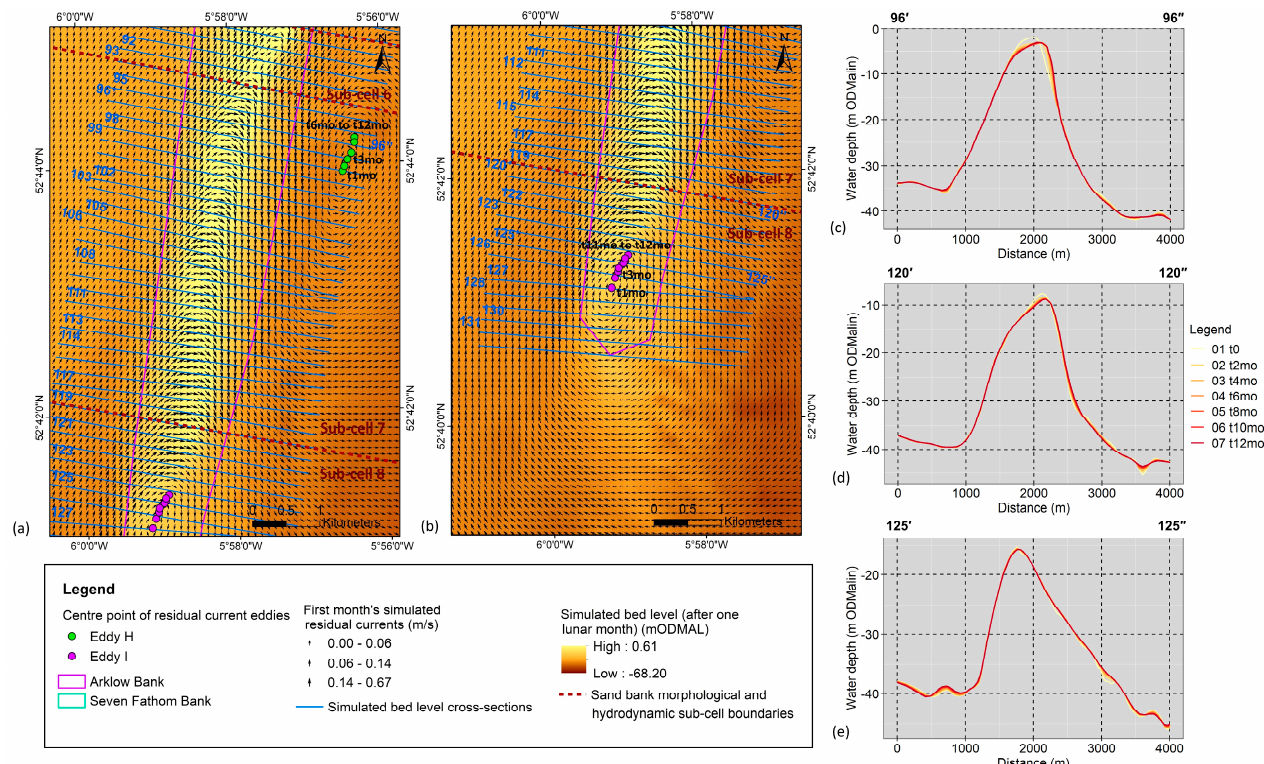
Figure 11. Morphodynamics and hydrodynamics at Sub-cells 7 and 8 of Arklow Bank. ( a , b ) Simulated bed level change after one lunar month and associated residual current vectors, overlain by the location of the centre point of residual eddies from residual currents during each subsequent lunar month simulation; ‘t6mo’ is the sixth lunar simulation month. ( c – e ) Simulated bed level over a one year simulation at cross-sections 96, 120 and 125; ‘t0’ is the starting bed level, and ‘mo’ is subsequent months.